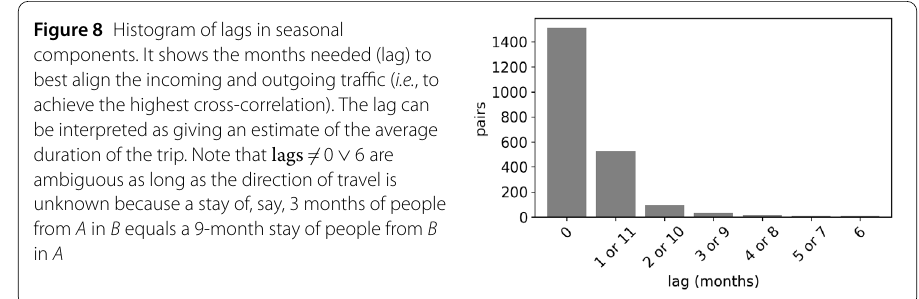
Figure 8 Histogram of lags in seasonal components. It shows the months needed (lag) to best align the incoming and outgoing traffic ( i.e. , to achieve the highest cross-correlation). The lag can be interpreted as giving an estimate of the average duration of the trip. Note that lags (cid:7) = 0 ∨ 6 are ambiguous as long as the direction of travel is unknown because a stay of, say, 3 months of people from A in B equals a 9-month stay of people from B in